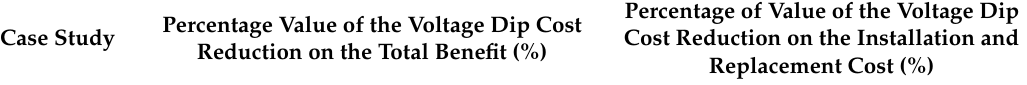
Table 6. Benefit corresponding to the voltage dip cost